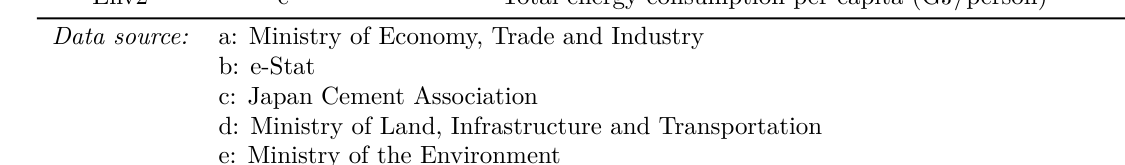
Table 2. Indicators for regional context analysis data from